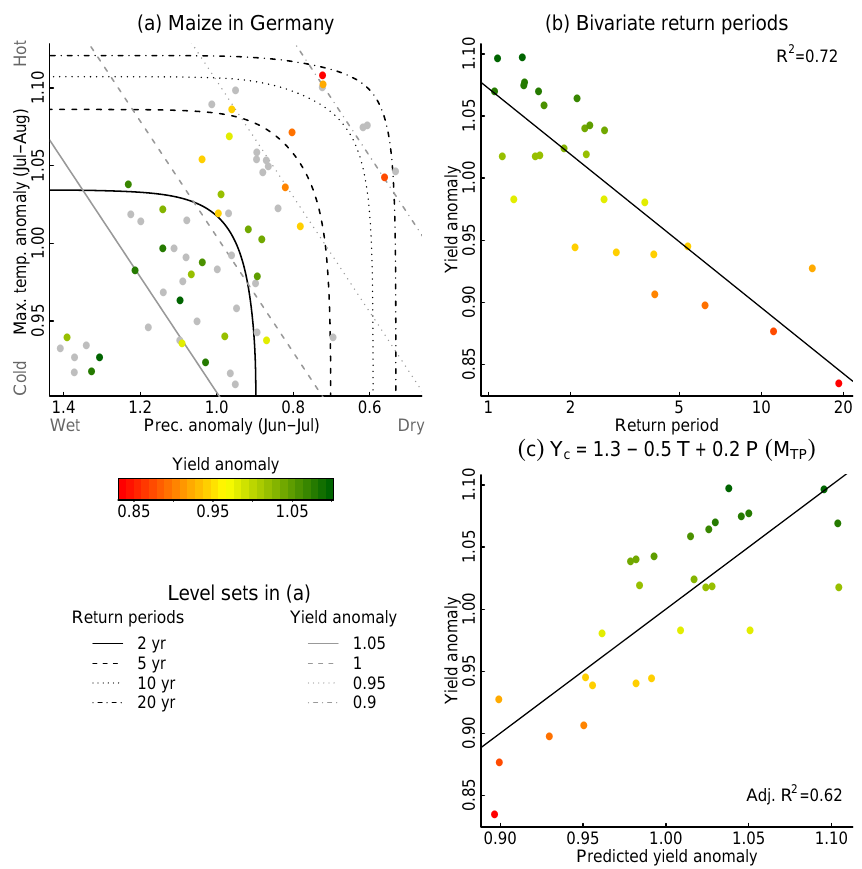
Figure 1. Maize in Germany. (a) Maximum temperature anomalies averaged over July and August vs. precipitation anomalies averaged over June and July. Dots are coloured according to maize yield anomalies if yield data were available and are grey otherwise. Cold and wet conditions are on the lower left. Bivariate return periods increase from the lower left to the upper right as indicated by the curves. Straight lines indicate levels of equal yield anomalies as predicted by the linear model M TP . (b) Maize yield anomaly vs. bivariate return periods. The line indicates the best linear fit with R 2 = 0 . 72. (c) Linear model using predictors from (a) ( M TP ). The adjusted R 2 is 0.62. The line denotes the 1:1